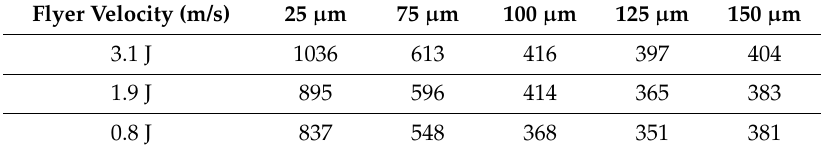
Table 3. Flyer velocities (m/s) with various laser energy and flyer thickness ( D = 2 mm, L = 100 µ m). Flyer Velocity (m/s)